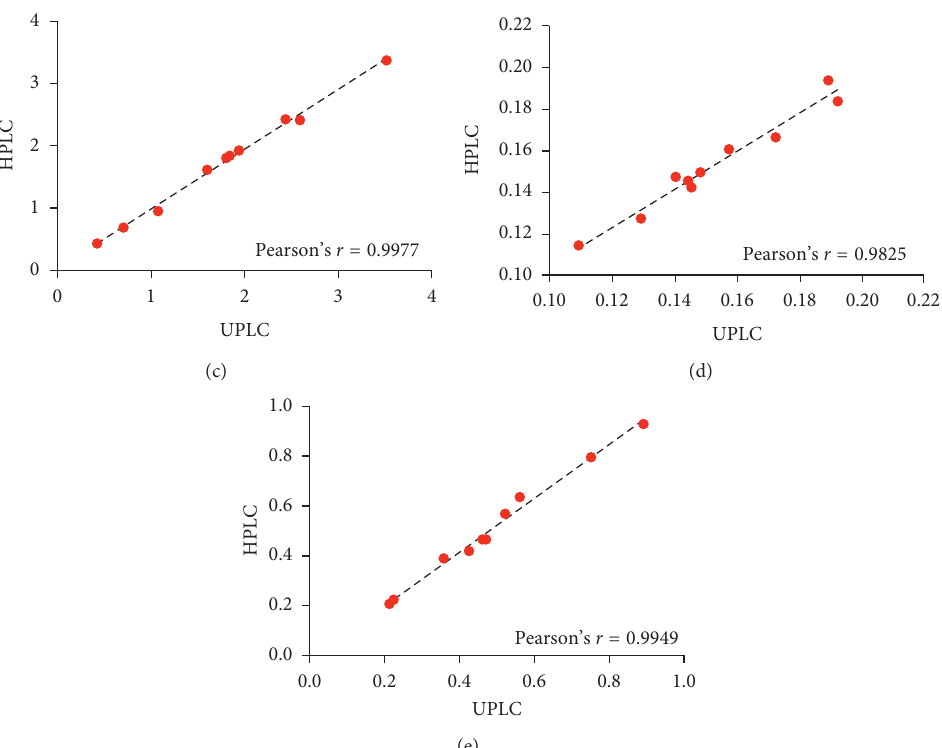
Figure 4: The similarity of detection results of different compounds by different chromatographic systems. (a) C (e) C 5